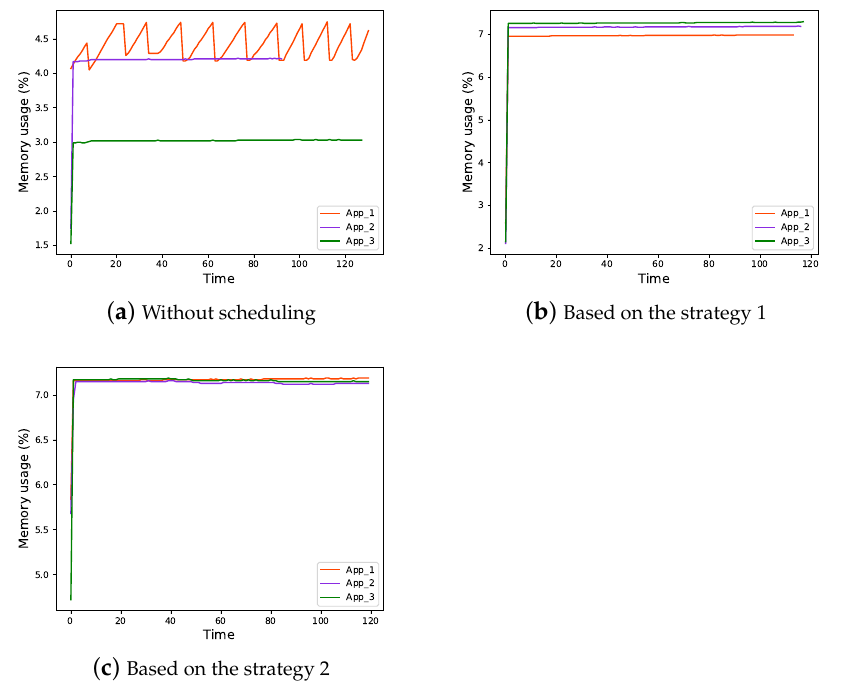
Figure 15. Memory usage of each App.